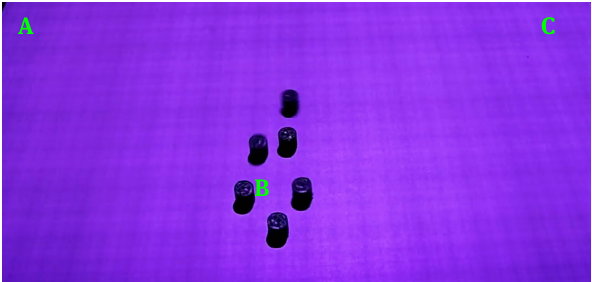
Figure 4: Six Zooids moving toward the user to form a figure. The green letters show the successive goals covered by each motion sequence.